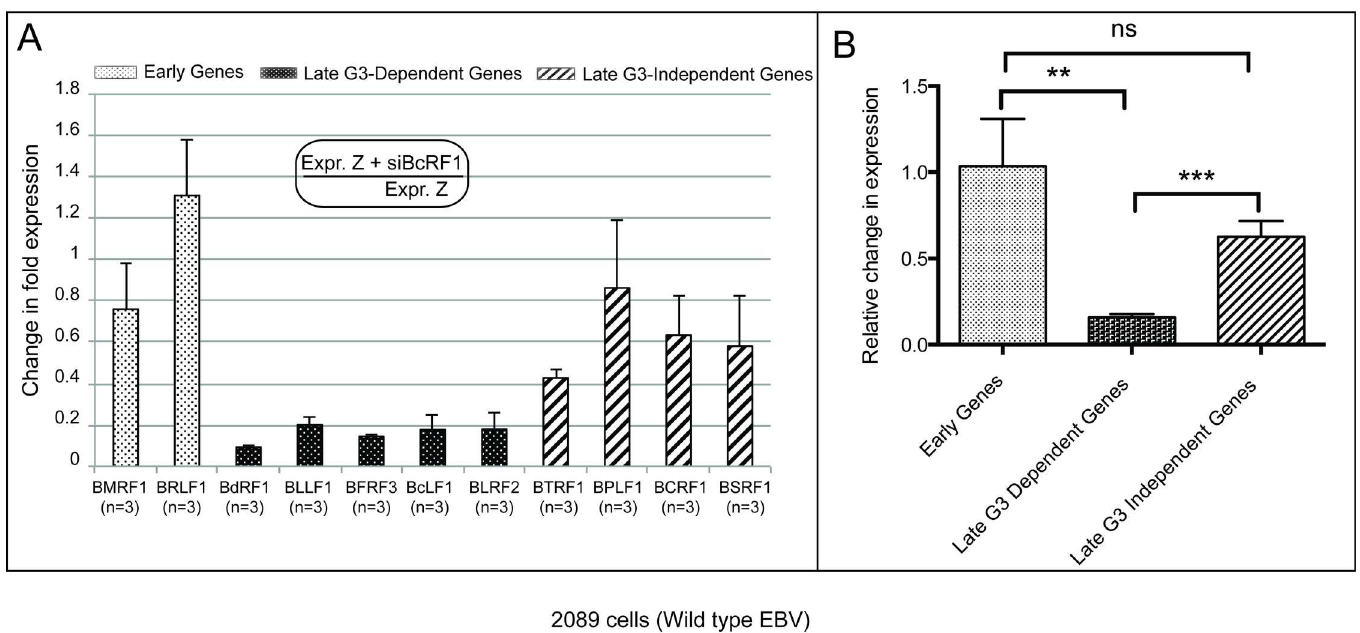
Fig 6. Expression of the four late BGLF3-independent genes does not require BcRF1, the EBV-encoded TBP-like protein. A) The effect of silencing expressionof BcRF1 on the level of eleven lytic transcripts was determined by RT-qPCR. Two of these transcripts are expressedearly (BRLF1 and BMRF1); nine transcripts are expressedlate. Of the nine late transcripts, five are BGLF3-dependent(BdRF1, BLLF1, BFRF3, BcLF1, BLRF2) and four are BGLF3-independent(BTRF1, BPLF1, BCRF1, and BSRF1). Expression of these genes was determined using RT-qPCR of mRNA purifiedfrom 2089 cells transfected with ZEBRA or ZEBRA plus siBcRF1. The relative abundance of each transcript was calculatedusing the ΔΔ C T method. The fold-change in expressionof each transcript was determined by dividingthe relative abundance of each transcript in the absenceand presenceof siBcRF1. Letter (n) representsthe number of biological replicates. B) A graph illustrating combinedchanges in expressionamongthe three groupsof EBV lytic genesas a result of silencingBcRF1. Asterisks denotestatistically significantdifferences; ns, marks non-statistically significantdifference;G3, BGLF3, and Z,